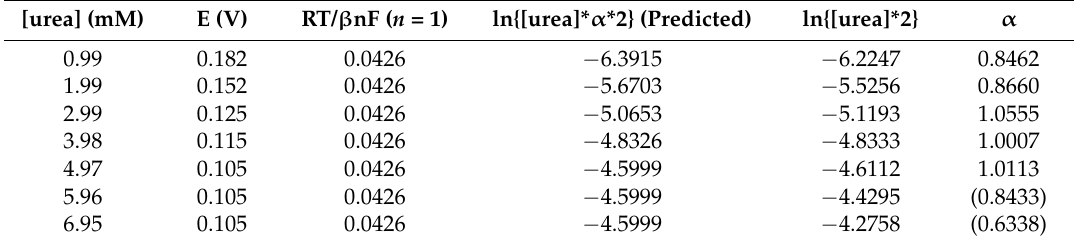
Table 1. Predicted and experimental values of ln{[urea]* α *2} and the activity coefficient ( α ). (T = 25.1 ◦ C). [urea] (mM) E (V) RT/ β nF ( n = 1) ln{[urea]* α *2} (Predicted) ln{[urea]*2} α 0.99 0.182 0.0426 − 6.3915 − 6.2247 0.8462 1.99 0.152 0.0426 − 5.6703 − 5.5256